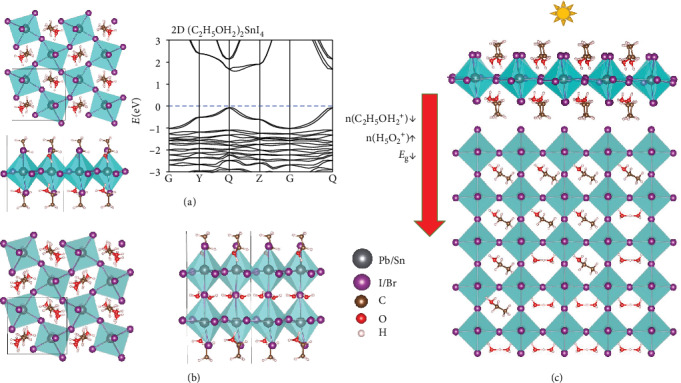
Geometric structure (top and side view) of the 2D (a) (C2H5OH2)2SnI4 with its band structure and (b) (H5O2)(C2H5OH2)2Pb2I7. (c) A sketch of design by dripping ethanol on the surface of (H5O2)SnI3 to form perovskite (side and top view). The red arrow denotes the dripping direction.